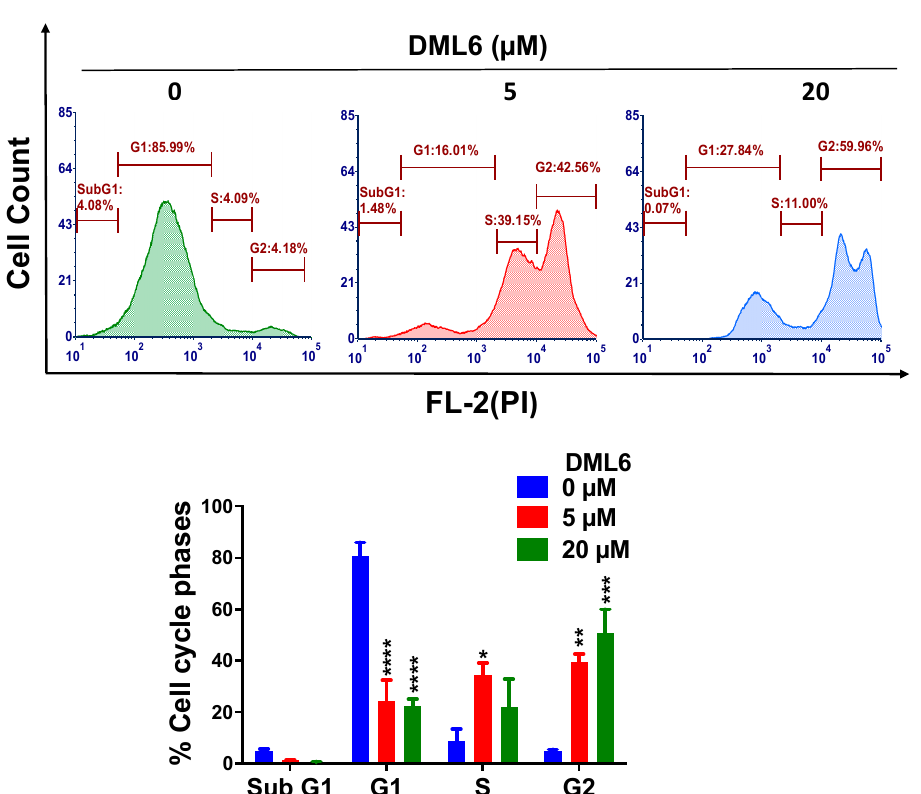
Figure 4. The effect of DML6 on the cell cycle. A representative figure illustrating the effect of DML6 on the distribution of the OV2008 cell populations in the cell cycle phases. OV2008 cells were incubated with the vehicle, 5 or 20 µ M of DML6 for 24 h and were subjected to cell cycle analysis using flow cytometry with propidium iodide (PI) (X-axis)/cell counts(Y-axis); A histogram quantitatively summarizing the change in the % of cells in each phase of the cell cycle due to DML6, is also shown. * p < 0.05, ** p < 0.01, *** p < 0.001, **** p < 0.0001. The data represent the means ± SEM of three independent experiments performed in